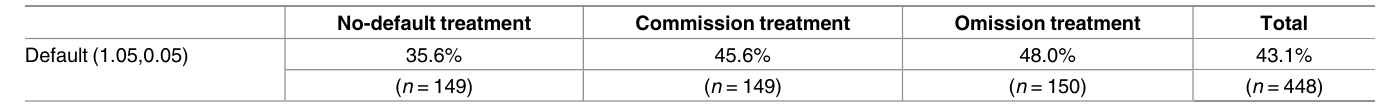
Table 6. Share of participants choosing the selfish allocation in Experiment 3.